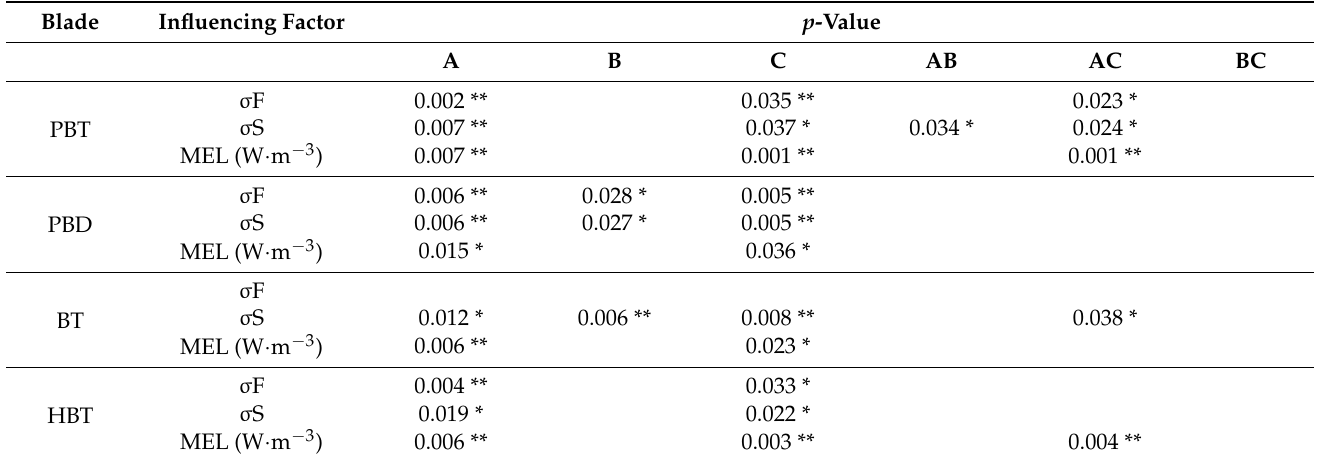
Table 2. Four kinds of blade influence factors and the p -value summary.